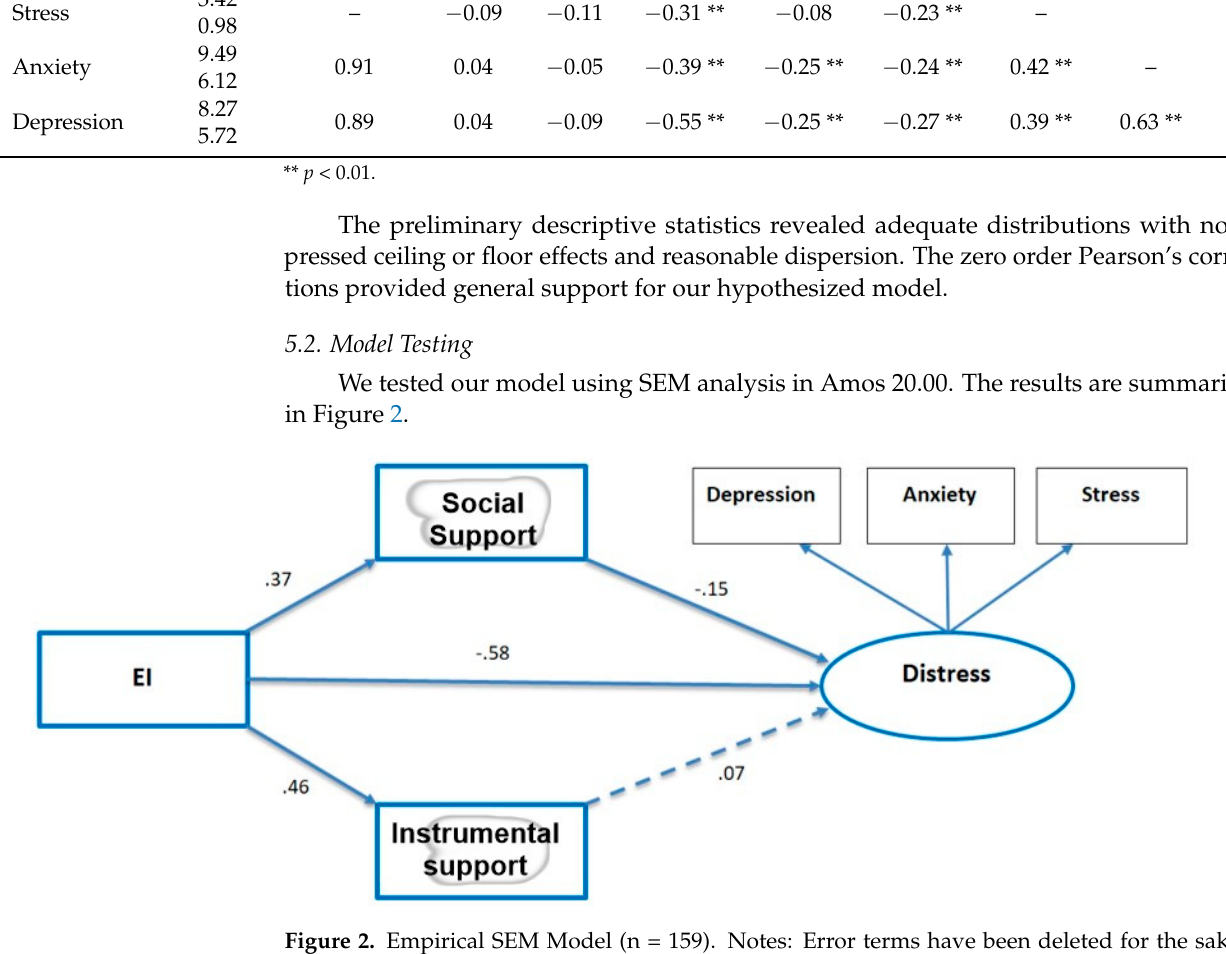
Figure 2. Empirical SEM Model (n = 159). Notes: Error terms have been deleted for the sake of clarity of presentation. All paths marked in solid lines are statistically significant at p < 0.04 or better. Component loadings on the latent distress factor: Stress = 0.70, Anxiety = 0.86, Depression = 0.84. Goodness of fit indices for the empirical model: Chi-square = 17.50, df = 6, p < 0.05. NFI = 0.95 CFI = 0.97, RMSEA = 0.06. Indirect effect of EI on distress = − 0.06; 95% CI = − 0.08/ − 0.04. Total effects of EI on distress = − 0.64 (r square =